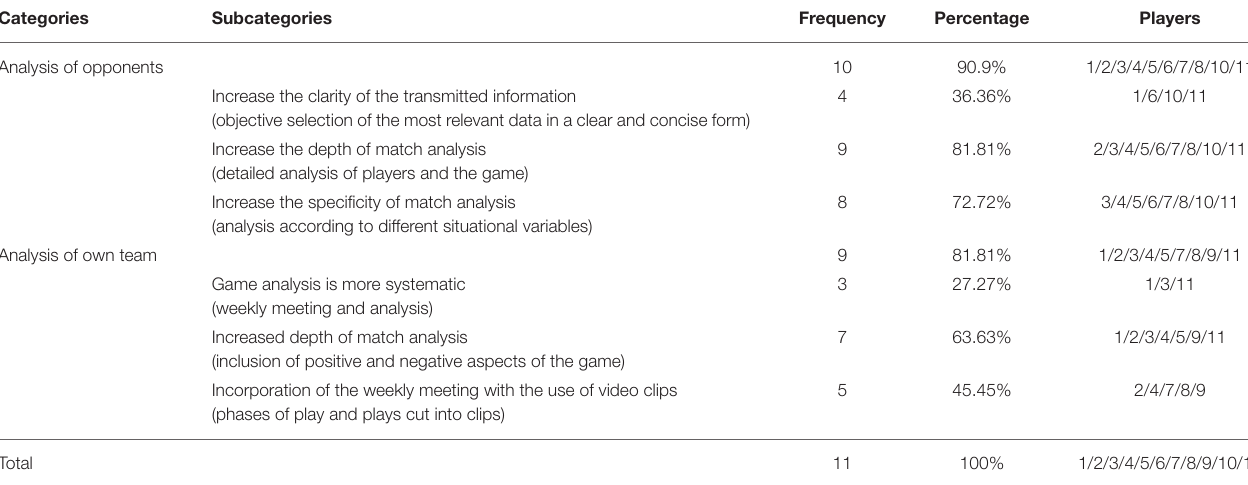
TABLE 6 | Descriptive analysis of the changes perceived by the players in the preparation and development for competition.